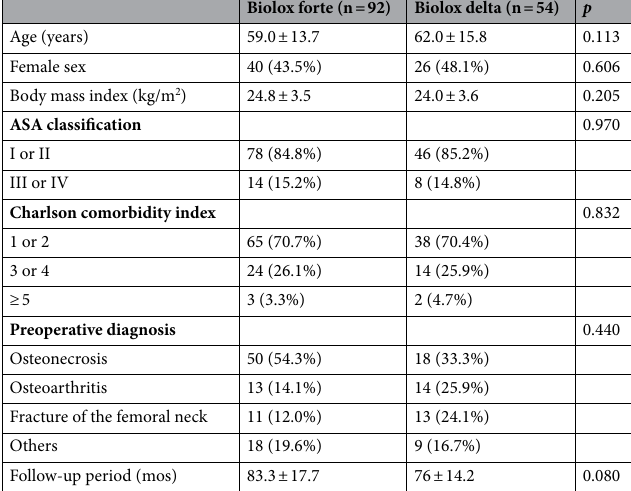
Table 1. Baseline patients characteristics.